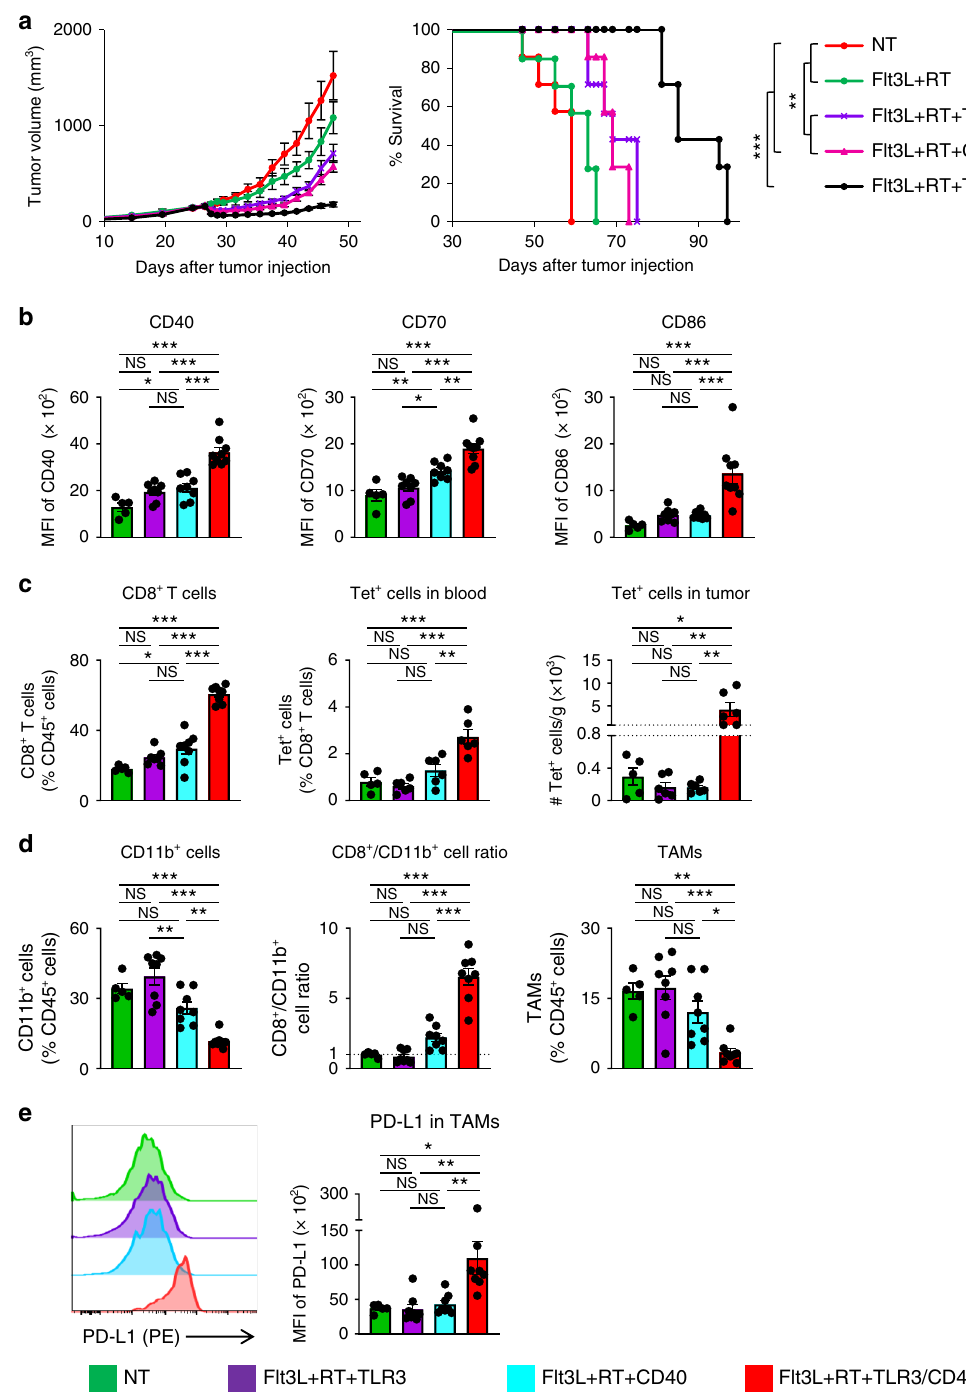
Fig. 4 Conversion of poorly T cell-in fi ltrated tumors requires dual TLR3/CD40 stimulation of Flt3L-induced DCs. a Tumor volume curves (mean) and survival curves in AT-3 tumor-bearing mice in different treatment groups as indicated. n = 7 mice in all groups. ** p < 0.01, *** p < 0.001 by a log-rank test. b Median fl uorescence intensity (MFI) of CD40, CD70, and CD86 in CD103 + DCs in tumor-draining lymph nodes (TdLN) of AT-3 tumor-bearing mice. n = 5 mice (NT), 7 mice (Flt3L + RT + TLR3, Flt3L + RT + CD40), and 8 mice (Flt3L + RT + TLR3/CD40). c Frequency of CD8 + T cells of CD45 + cells in AT-3 tumors, and frequency of gp70-speci fi c Tet + cells among CD8 + T cells in peripheral blood and numbers (per gram) of gp70-speci fi c Tet + cells in tumors of 4T1 tumor-bearing mice. n = 5 mice (NT), 8 mice (Flt3L + RT + TLR3, Flt3L + RT + CD40), and 9 mice (Flt3L + RT + TLR3/CD40) for CD8 + T cells in AT-3 tumors. n = 5 mice (NT) and 6 mice (any other groups) for Tet + cells. d , e Frequency of CD11b + cells of CD45 + cells, CD8 + T cell/CD11b + cell ratio, and frequency of tumor-associated macrophages (TAMs: Ly6c − class II + CD24 − F4/80 + ) of CD45 + cells ( d ), and MFI of PD-L1 in TAMs ( e ) in AT-3 tumors. n = 5 mice (NT) and 8 mice (any other groups). Tumors were harvested 5 – 7 days after TLR3/CD40 stimulation ( b – e ). NS not signi fi cant, * p < 0.05, ** p < 0.01, *** p < 0.001 by one-way ANOVA with Tukey ’ s multiple comparisons ( b – e ). Data shown are representative of three independent experiments. Mean± SEM. Source data are provided as a Source Data fi